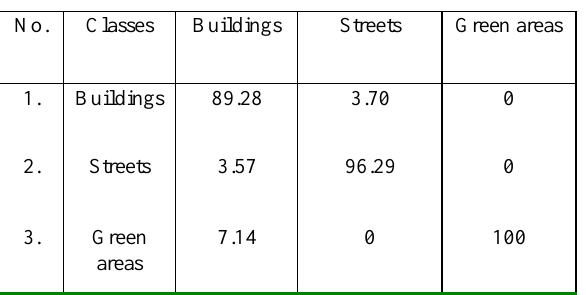
Table 8 . Omission error for the image from 2017 • User’s accuracy is calculated by reviewing the sites for correct classifications and dividing them by the total number of classified sites for each class (Table 9, Table 10).